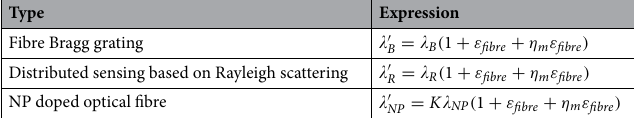
Table 1. The expressions comparison among different types of fibres.